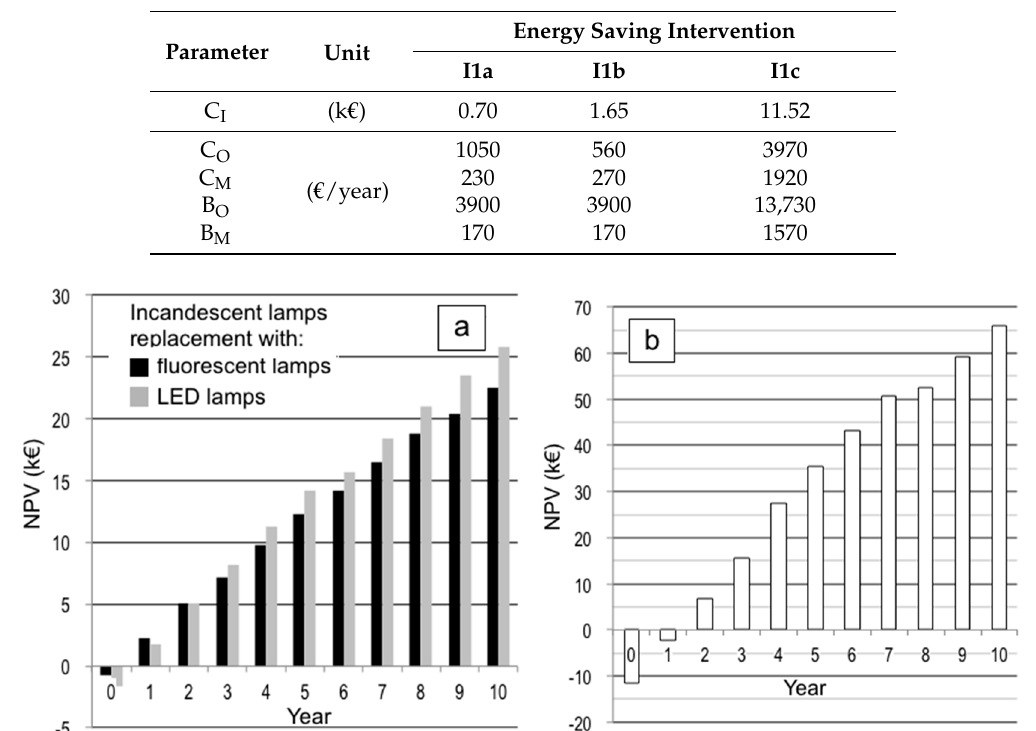
Figure 7. ( a ) Values of NPV as a function of time in the case of incandescent lamps replacement; and ( b ) both incandescent and fluorescent lamps replacement.